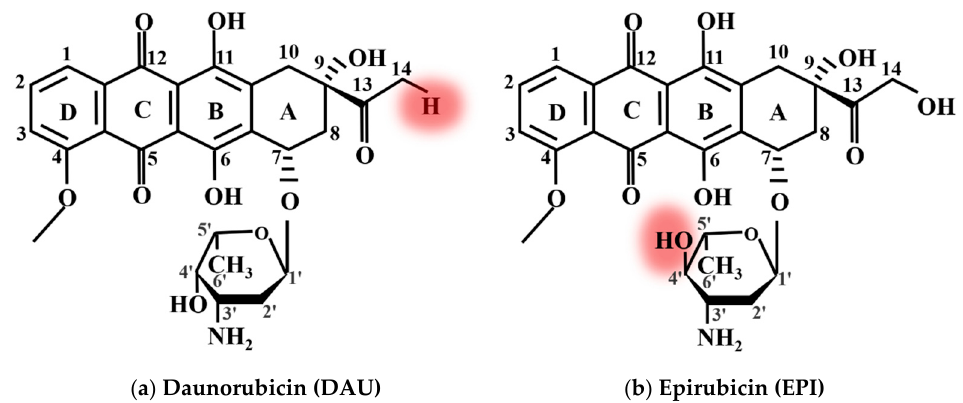
Figure 4. The molecular structure of ( a ) DAU and ( b ) EPI. Figure 5a–c are the Raman spectra of DOX, DAU and EPI, respectively. In Figure 5, the black curve represents the average Raman spectrum of DOX solution; the red curve represents the average Raman spectrum of DAU solution; the blue curve represents the average Raman spectrum of EPI solution.